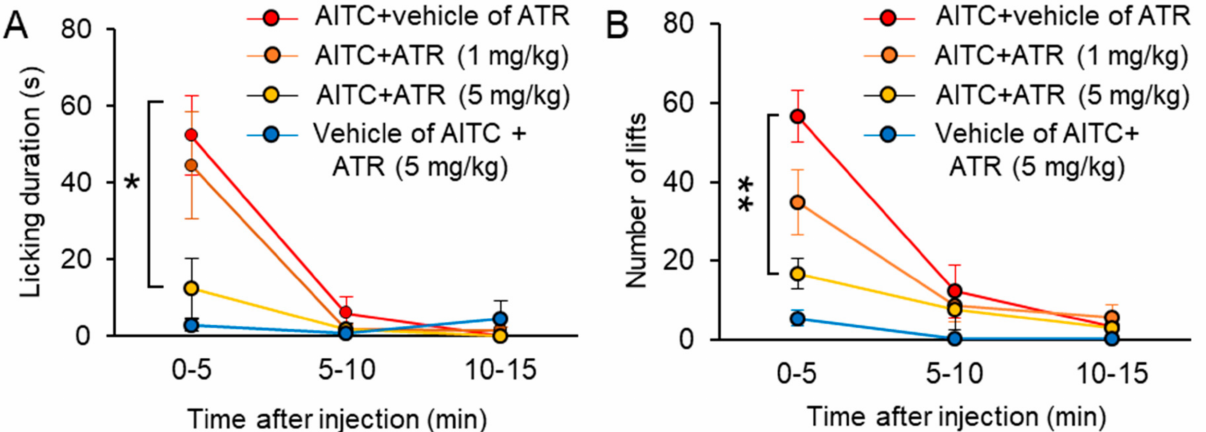
Figure 6. Systemic administration of atractylodin-attenuated AITC-induced nociceptive behavior in rats with dose- dependency. ( A , B ) Time course of nociceptive behavior induced by intraplantar injection of 5 mM AITC or vehi- cle of AITC following intraperitoneal injection of different doses of atractylodin (1 mg/kg, orange; 5 mg/kg) or ve- hicle of ATR (blue). The line graphs showing licking duration ( A ) and numbers of lifts ( B ) over time (post injec- tion of AITC). Data represent mean ± standard error of mean, * p < 0.05, ** p < 0.01 (AITC + vehicle of ATR vs. AITC + ATR at 0–5 min, one-way analysis of variance with the Tukey post hoc test). AITC: allyl isothiocyanate; ATR: